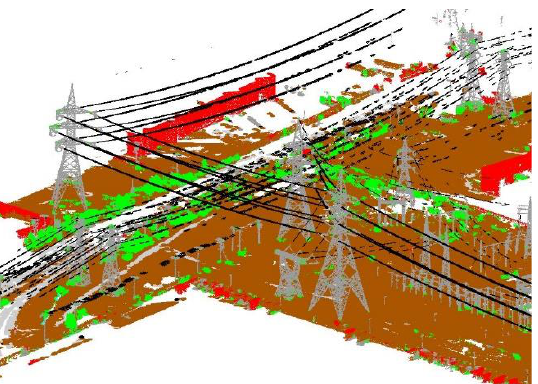
Figure 2. Location #1 after multi-source semantic segmentation.